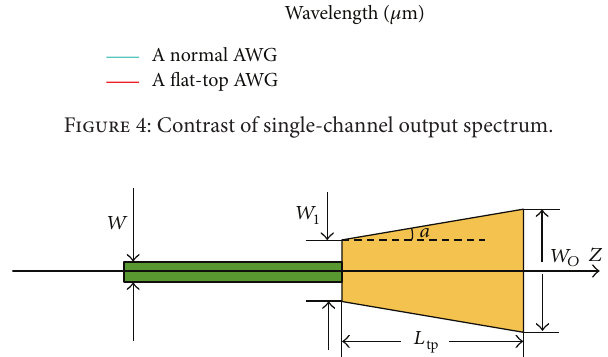
Figure 5: Geometrical configuration of a tapered